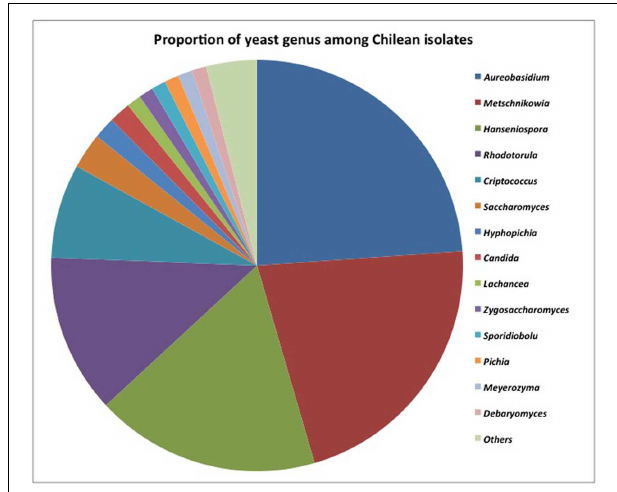
FIGURE 3 | Distribution of isolates retrieved from different Chilean valleys among yeast